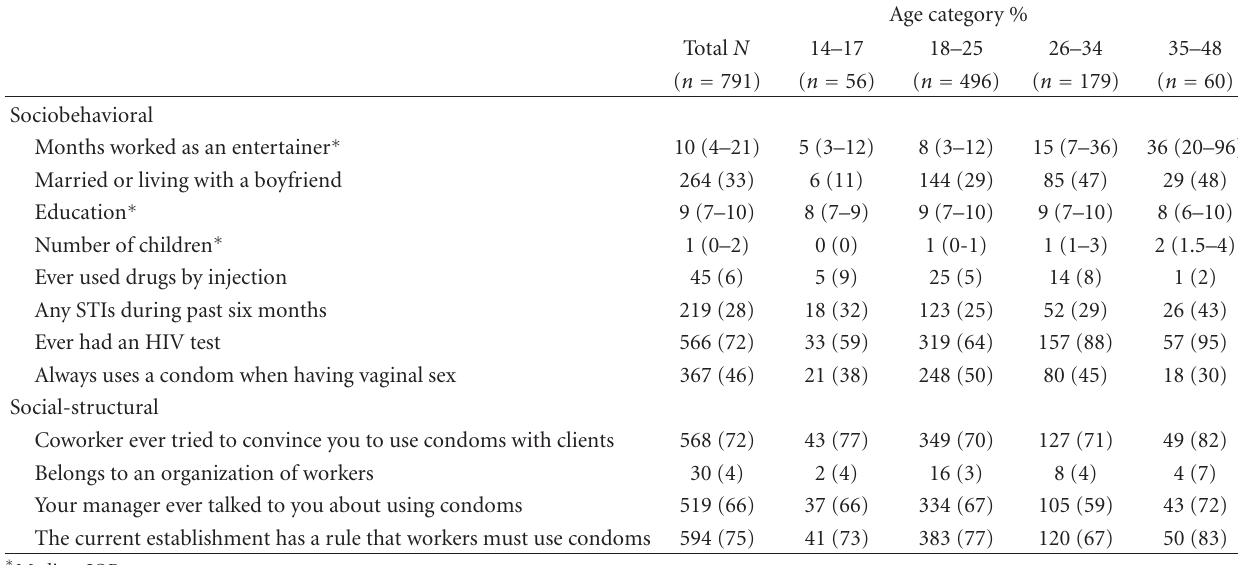
Table 1: Sociobehavioral and social-structural characteristics of female sex workers in the southern Philippines by age category ( N = 791).